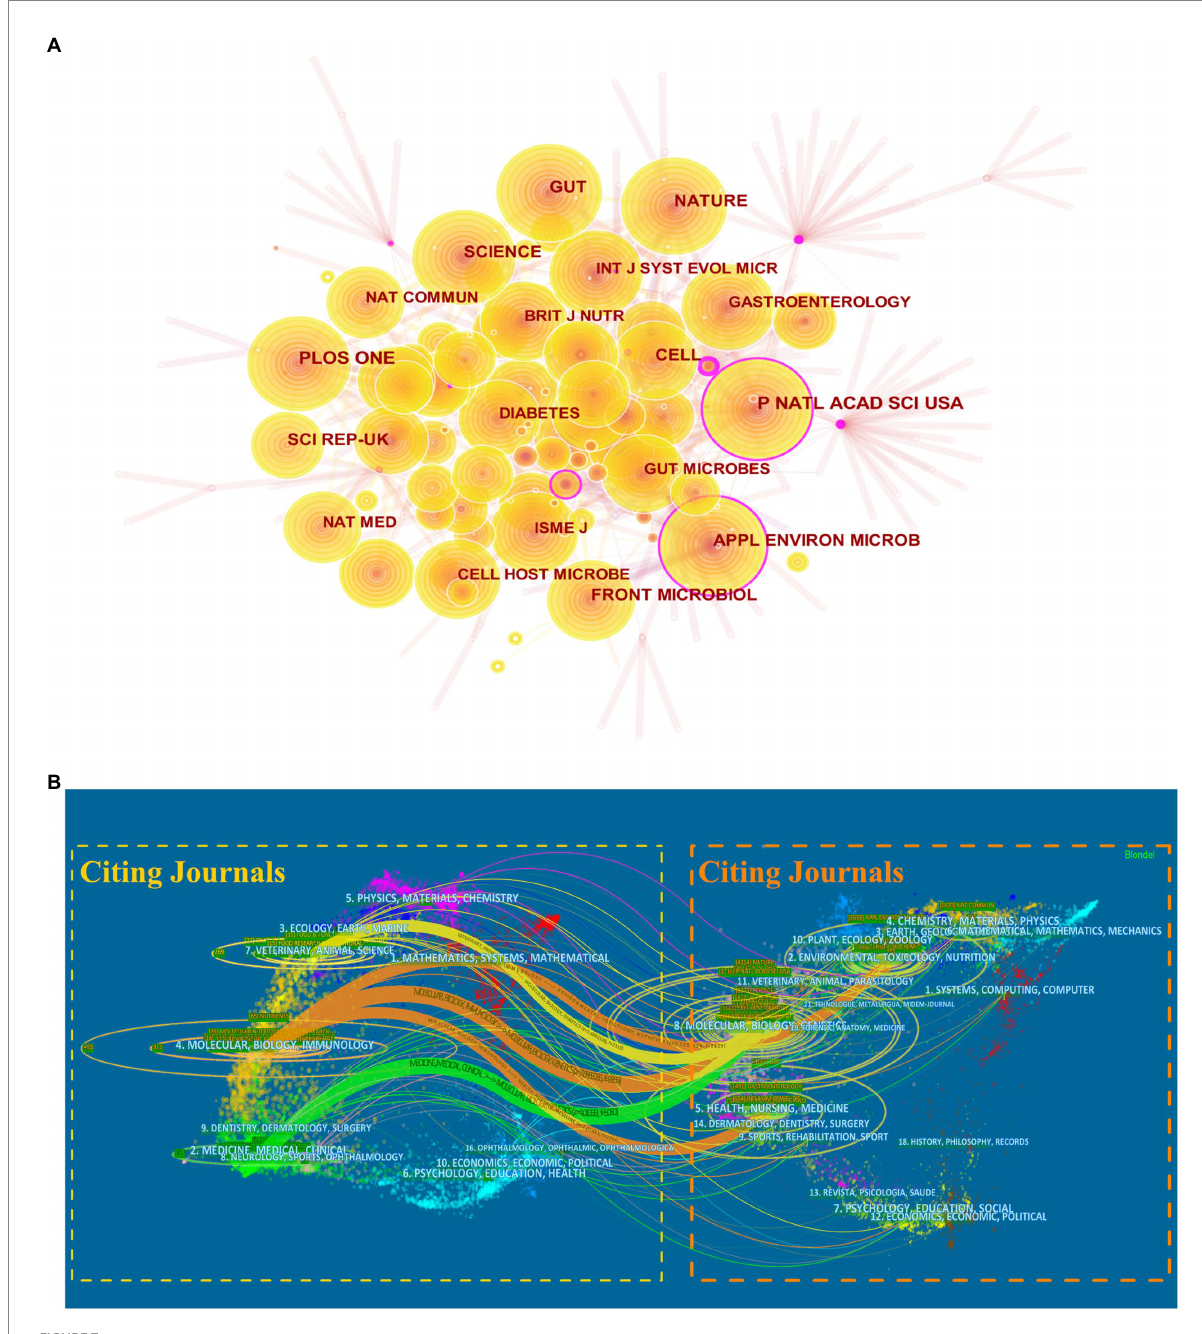
FIGURE 7 Analysis of core journals of A. muciniphila research. (A) Co-citation analysis of journals. Each node represents a different journal. The size of the nodes is weighted by the number of citations. The purple outer circle highlights nodes with intermediary centrality greater than 0.1. (B) Dual-map overlay of the journals publishing A. muciniphila articles generated by CiteSpace. Each label indicates a separate research subject covered by the journal. On the map, the left side represents the citing journals, while the right side represents the cited journals. There are different colored lines for the different reference paths, which begin with the citing map and end at the cited